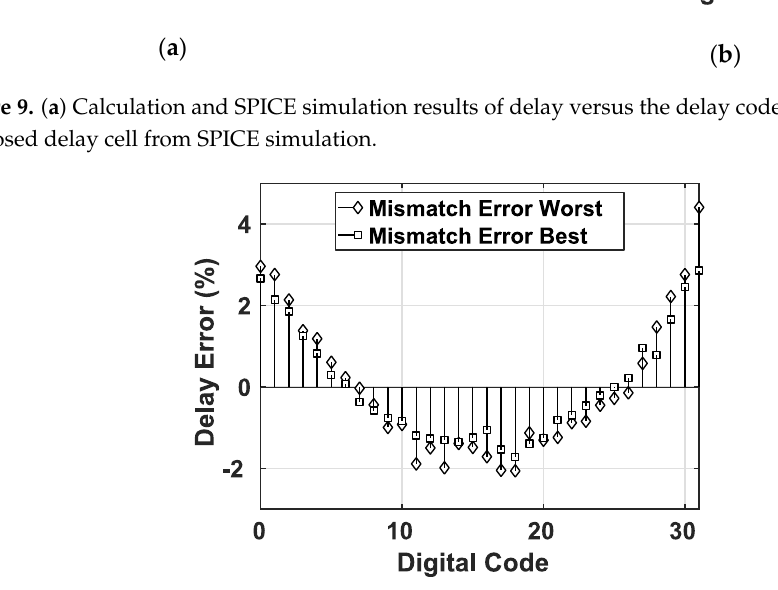
Figure 10. Worst and best linearity of proposed delay cell from Monte Carlo simulation.